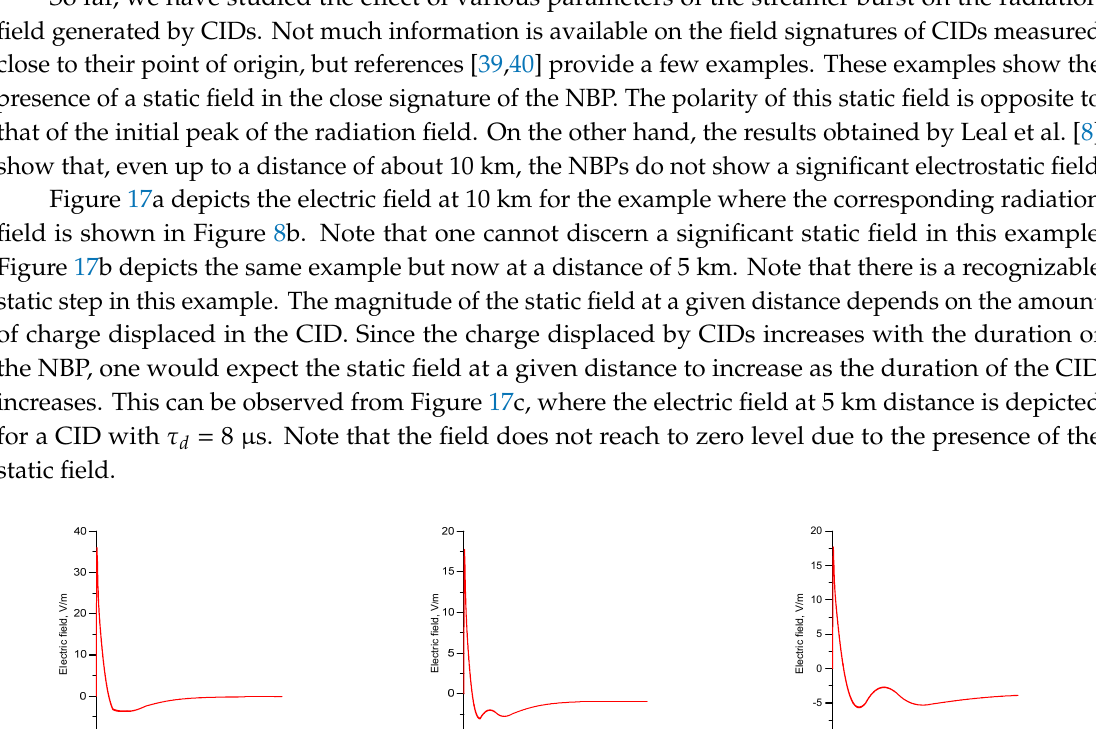
Figure 16. ( a ) Frequency spectrum of the radiation field without taking into account the randomness of the streamer breakdown. The spectra were range normalized so that 0 dB corresponds to 1 (V / m / Hz) at 100 km; ( b ) frequency spectrum of the radiation field including the randomness of the streamer breakdown. The spectra were range normalized so that 0 dB corresponds to 1 (V / m / Hz) at 100 km.